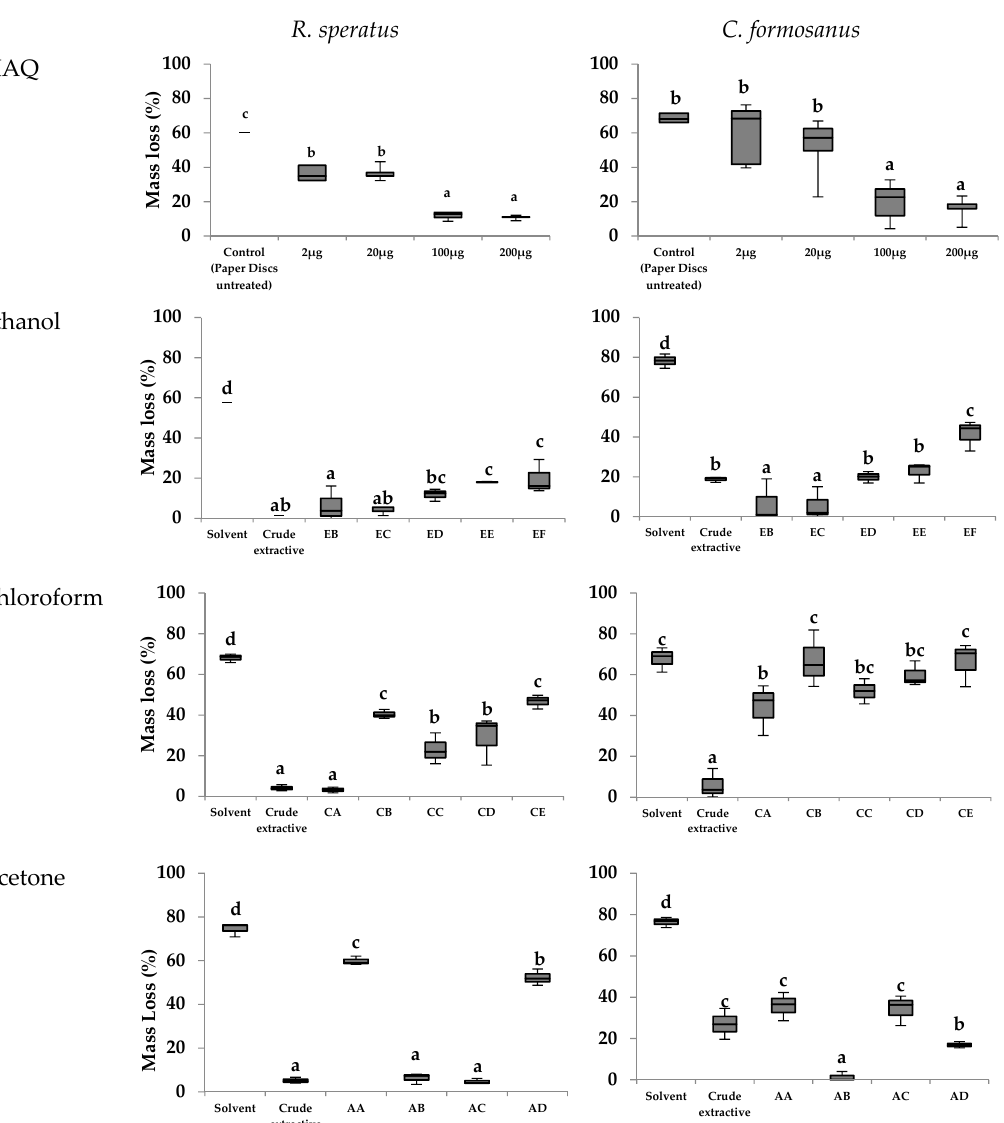
Figure 4. Box plot of the mass loss registered in R. speratus and C. formosanus no-choice feeding tests using fractions of T. grandis crude extractives and MAQ. Notes: Treatments with the same letters in the same graphic are not statistically different at p < 0.05, as determined by Duncan’s test; EB-EF, CA-CE, and AA-AD are referred to Figure 1 and Table 2; Dosages of extractives and MAQ are indicated in Table 2.